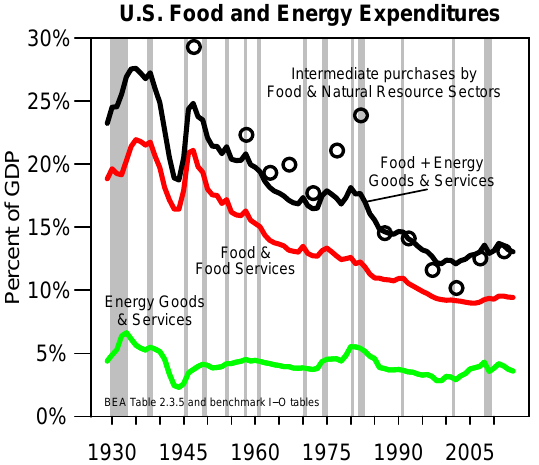
Figure 2. The quantity of personal consumption expenditures (PCE) for food and energy services in the United States as a fraction of US gross domestic product from 1929 to 2014. The gray bars represent time periods of US recession. The data plotted as lines are personal consumption expenditures (components of GDP) from Table 2.3.5 of the Bureau of Economic Analysis [60]. The data as circles represent intermediate purchases (not components of part of GDP) by food and energy sectors from harmonized BEA input-output